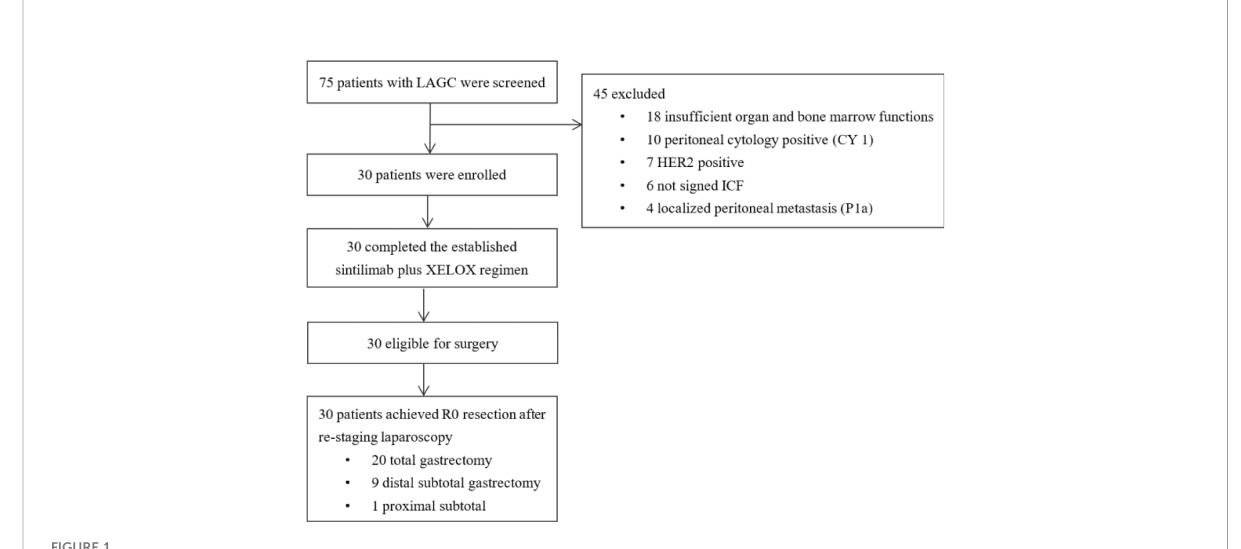
FIGURE 1 Study fl ow chart.